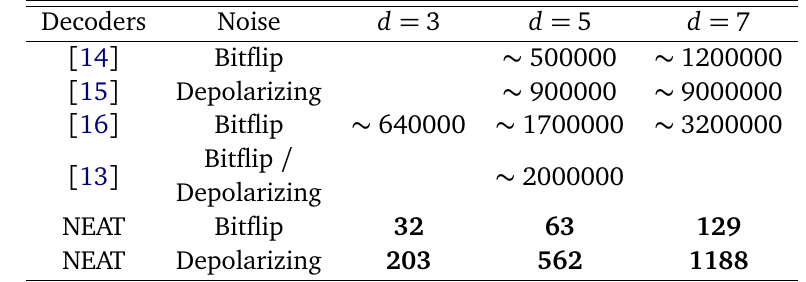
Table 1: Number of parameters of the deep Q-networks and of the policy-neural- networks found by the NEAT